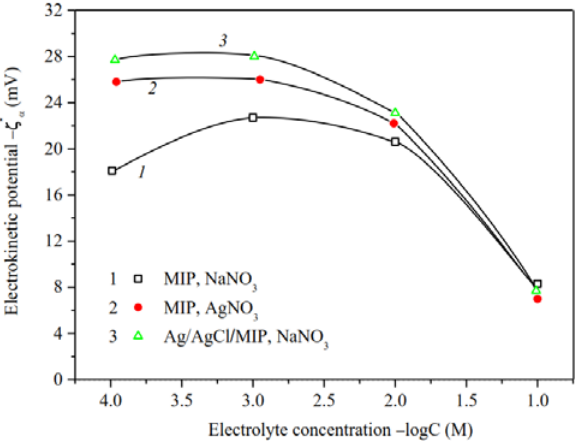
Figure 10. Electrokinetic potential of the base (Ermakova, 2022. Ref. {34]) and Ag/AgCl-modified MIP membranes vs. the concentration of NaNO 3 and AgNO 3 solutions.